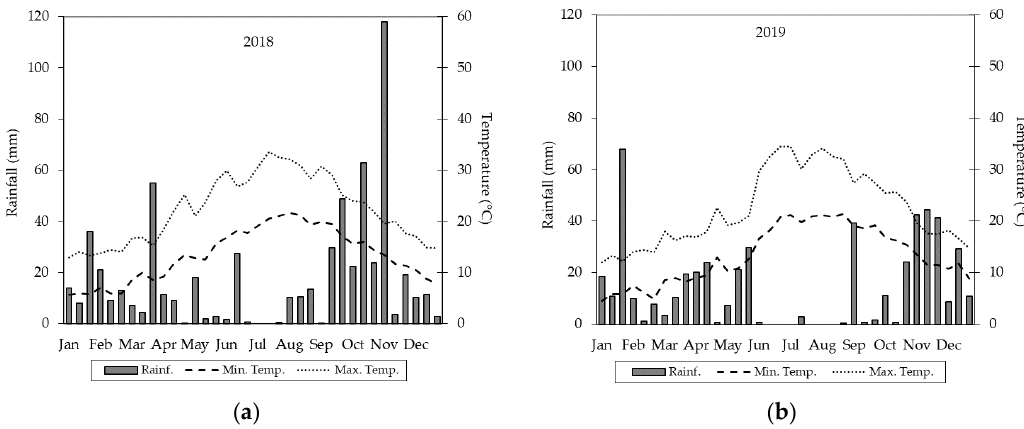
Figure 5. Rainfall and temperature trends during the test period in ExpA_1. Graph ( a ) refers to 2018, while graph ( b ) refers to 2019.